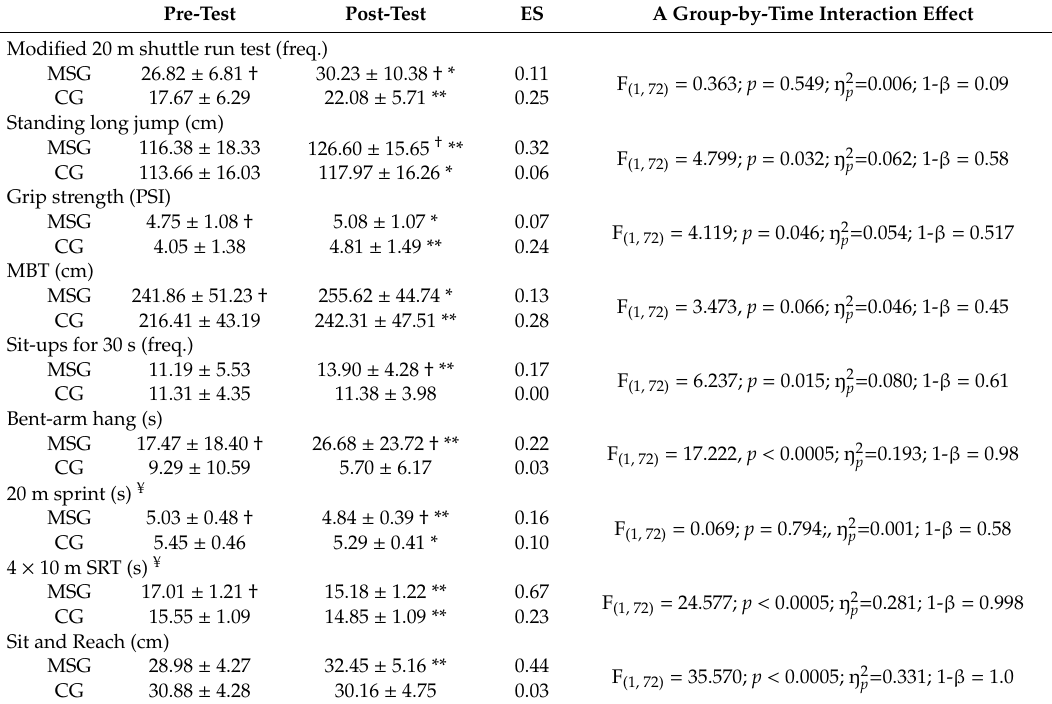
Table 3. Di ff erences between MSG (n = 38) and CG (n = 36) in physical performance measures from pre- to